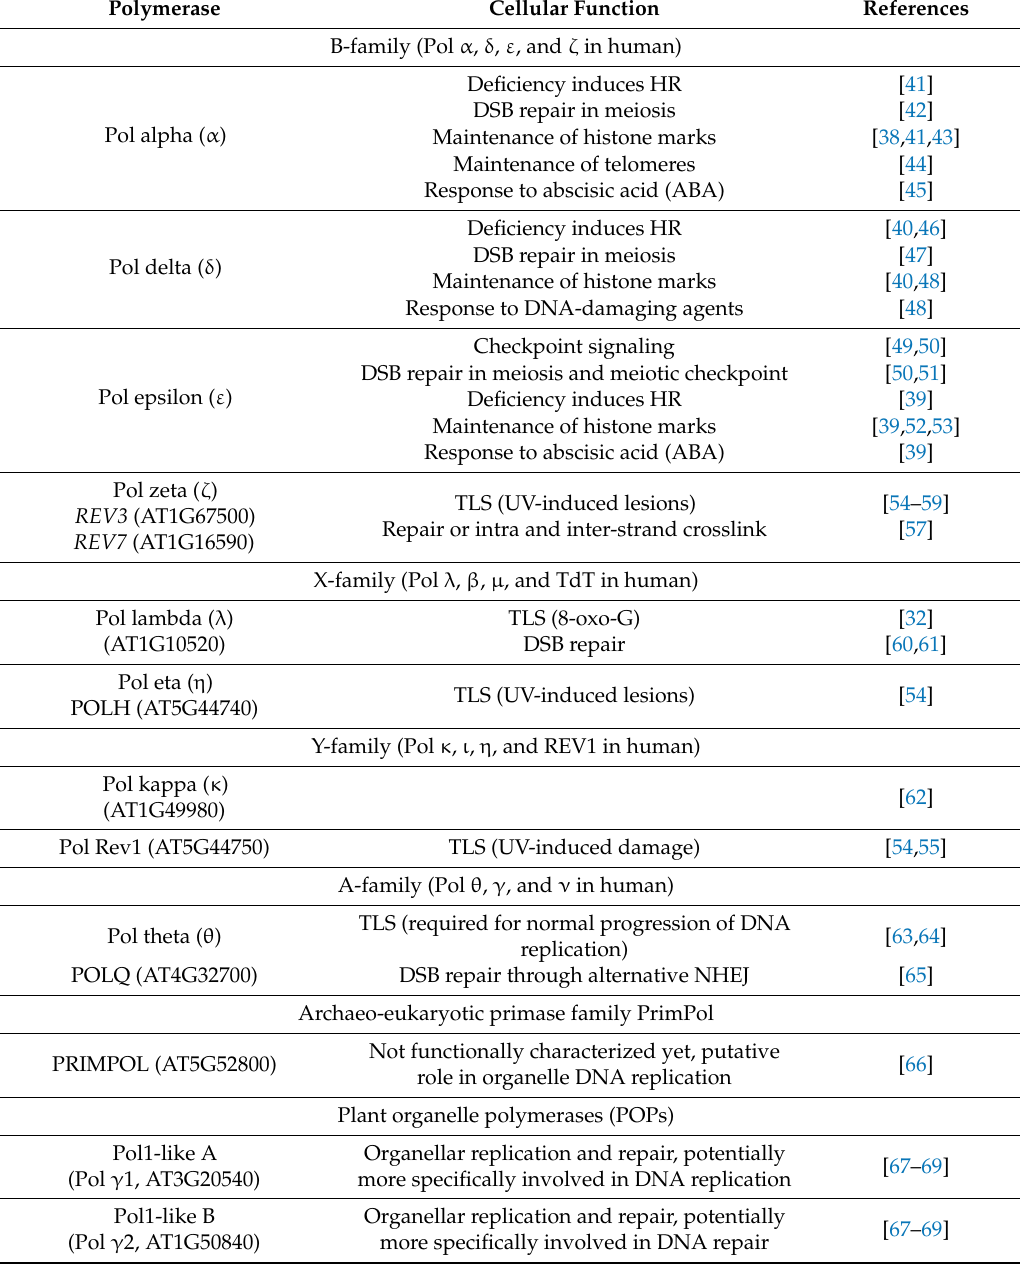
Table 2. Known functions of Arabidopsis replicative and specialized polymerases. HR—homologous